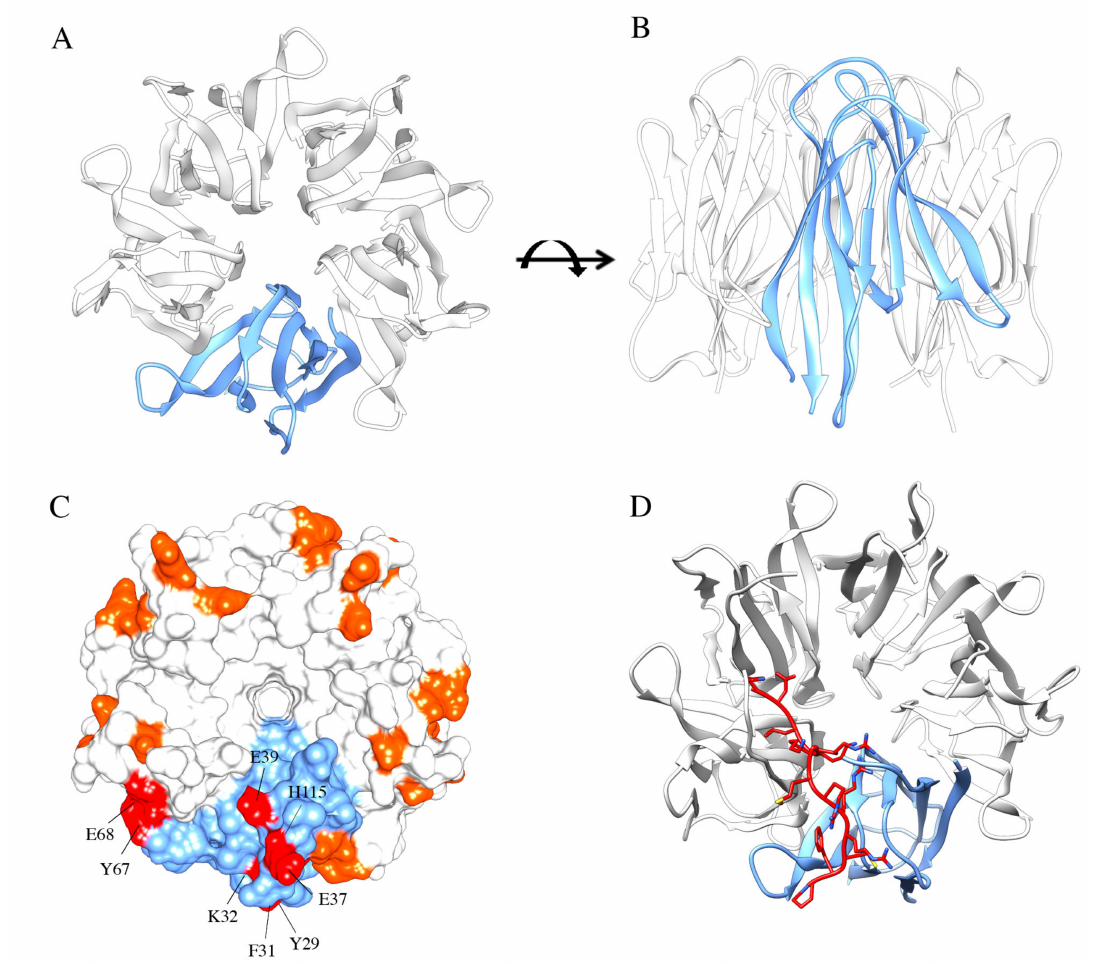
Figure 3. NPM1 N-terminal domain and interaction with arginine-rich motifs. NPM1 N-terminal domain (NTD) consists of eight antiparallel beta-strands forming a jellyroll barrel. Monomers associate to form a homopentamer, here represented from above ( A ) and in front view ( B ). ( C )